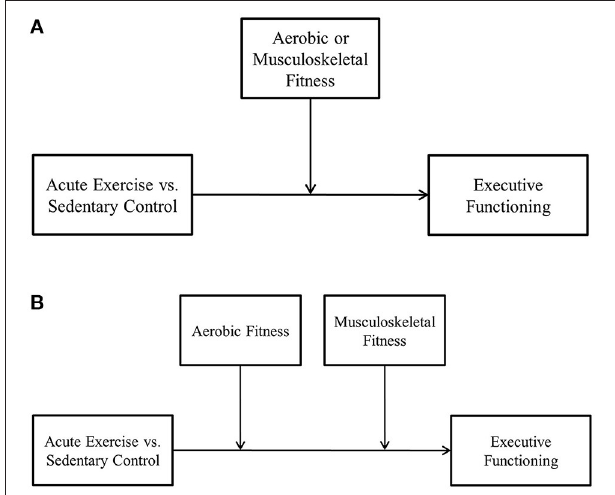
FIGURE 1 | (A) Acute exercise—executive functioning single moderation example. (B) Acute exercise—executive functioning additive moderation